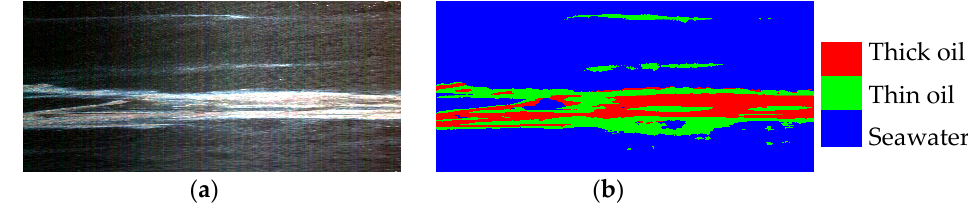
Figure 2. Oil spill dataset 1. ( a ) False-color image and ( b ) ground-truth image. Figure 3. Oil spill dataset 2. ( a ) False-color image and ( b ) ground-truth image.